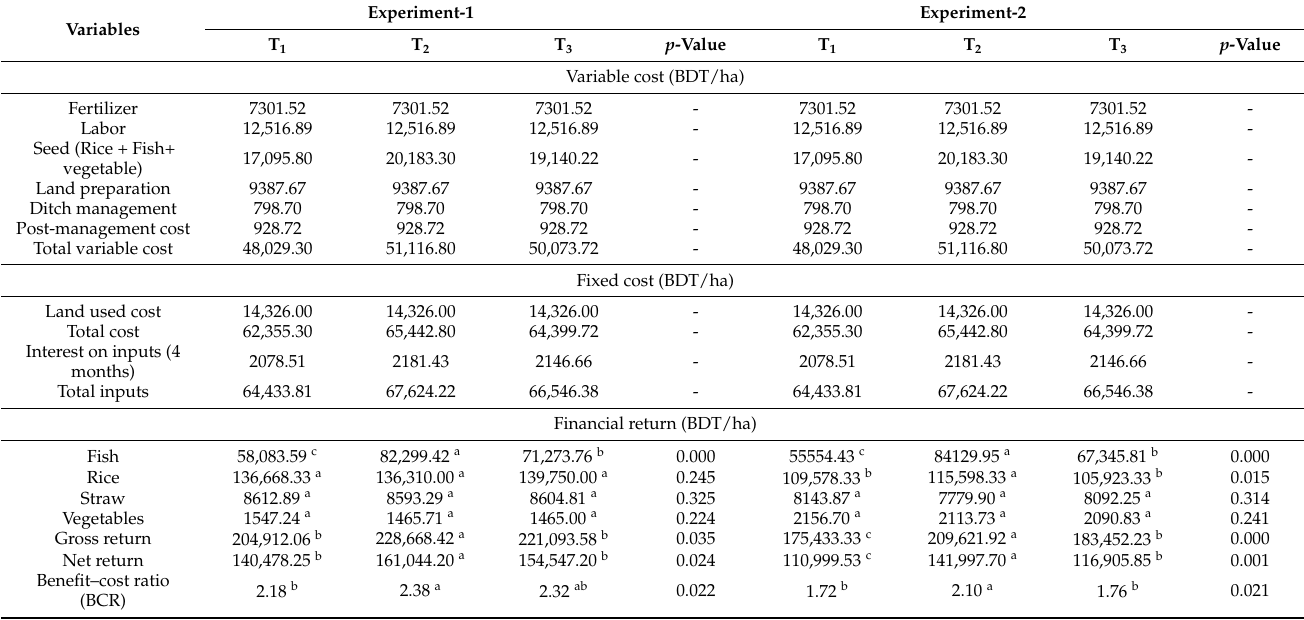
Table 6. Comparison of economic parameters among the treatments of experiment-1 and 2 in a rice–fish–vegetable culture system (1 ha rice field and 120 days of experimental